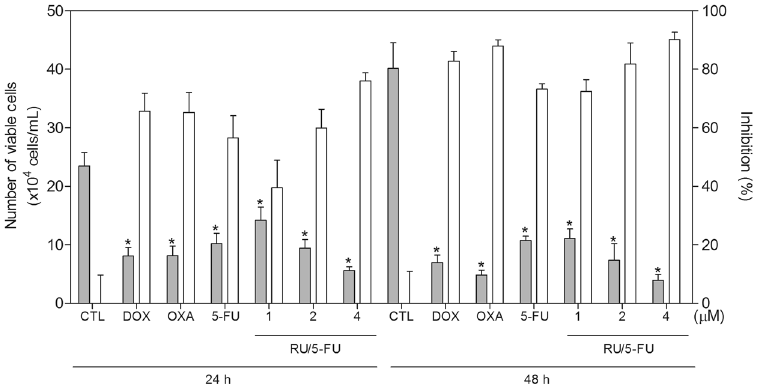
Figure 3. Effect of the complex [Ru(5-FU)(PPh 3 ) 2 (bipy)]PF 6 (RU/5-FU) in the cell viability of HCT116 cells determined by trypan blue staining. The gray bars represent number of viable cells (x10 4 cells/mL) and the white bars represent cell inhibition (%). The negative control (CTL) was treated with the vehicle (0.1% DMSO) used for diluting the compound tested. Doxorubicin (DOX, 1 µ M), oxaliplatin (OXA, 2.5 µ M) and 5-fluorouracil (5-FU, 4 µ M) were used as the positive controls. Data are presented as the mean ± S.E.M. of three independent experiments performed in duplicate. * P < 0.05 compared with the negative control by ANOVA followed by Student Newman-Keuls test.